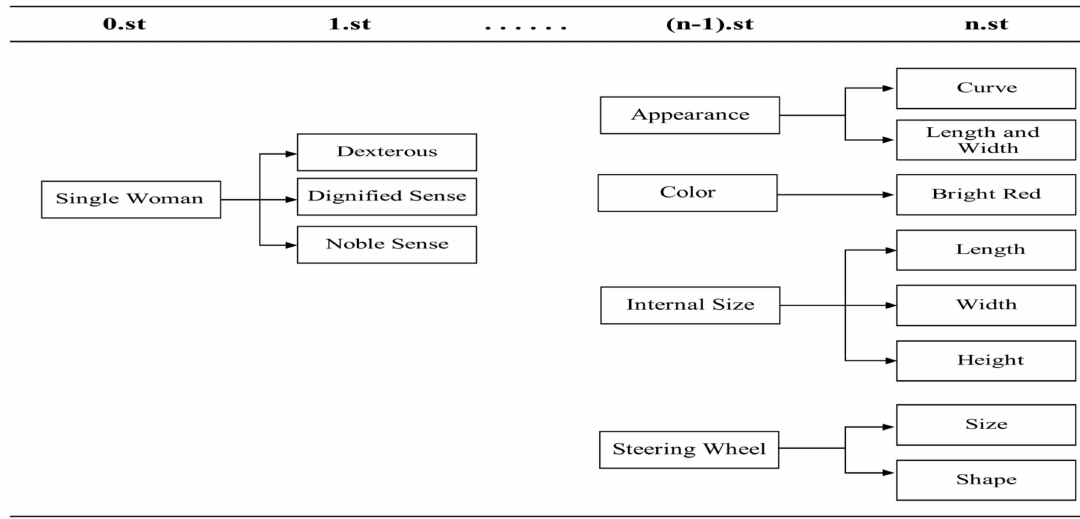
Figure 1. The hierarchical analysis of affective